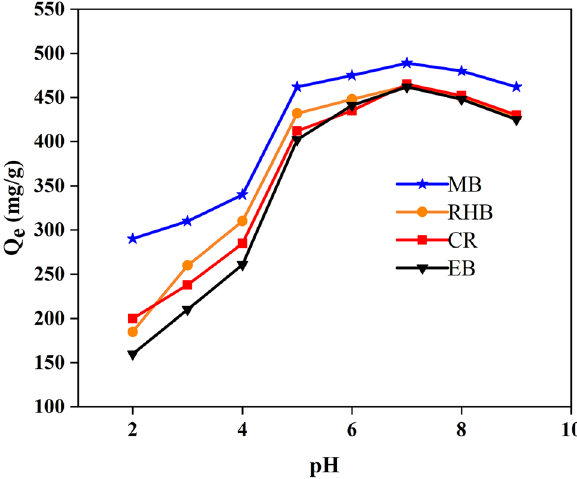
Fig. 4 Effect of PAA/PAM/[DMAEMA]MA hydrogel addition on RR(%)